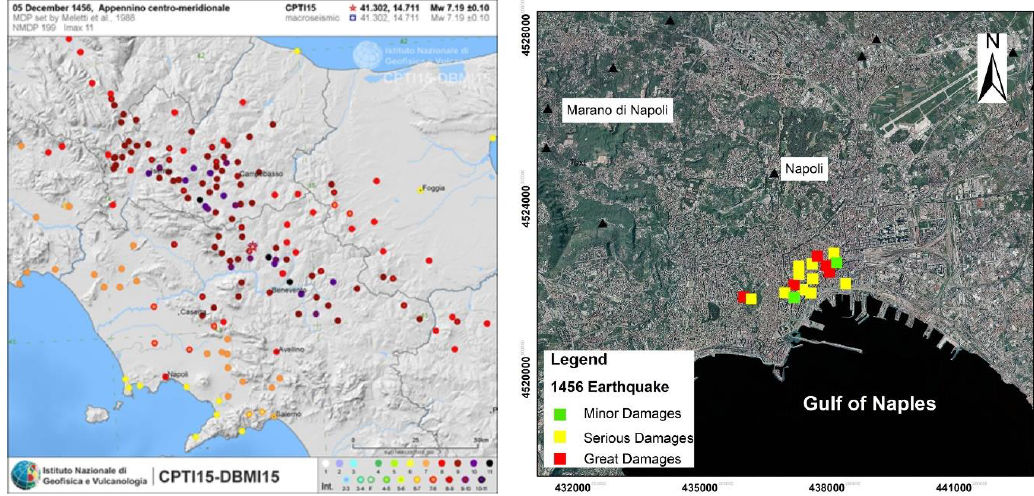
Figure 4. Map of the 1456 Mercalli-Cancani-Sieberg (MCS) macroseismic intensity (modified from [1]) on the left; map of the damage to Naples from the earthquake of 5 December 1456 on the right.